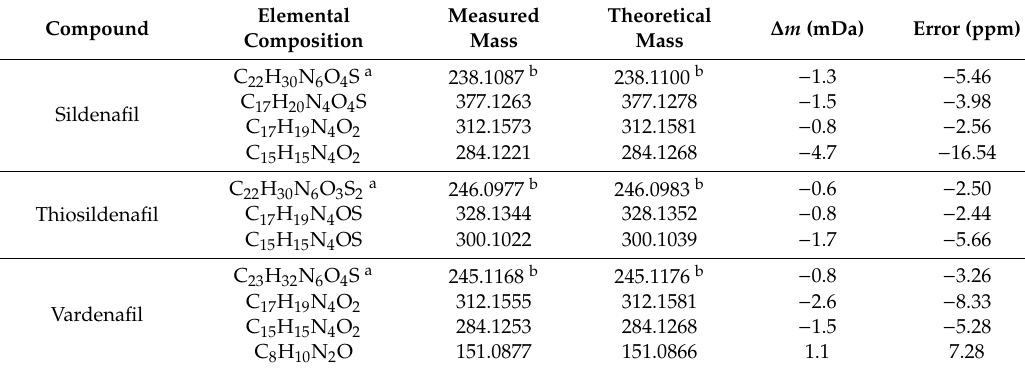
Table 4. Accurate masses and mass errors for fragment and precursor ions of PDE-5 inhibitors and their